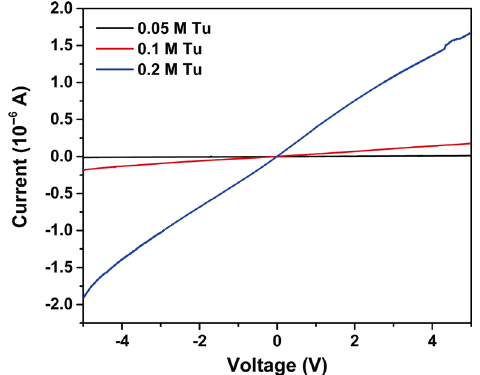
Fig. 3 I – V characteristics of the sensors based on samples prepared in precursor with Tu concentration of 0.05, 0.1, and 0.2 M.